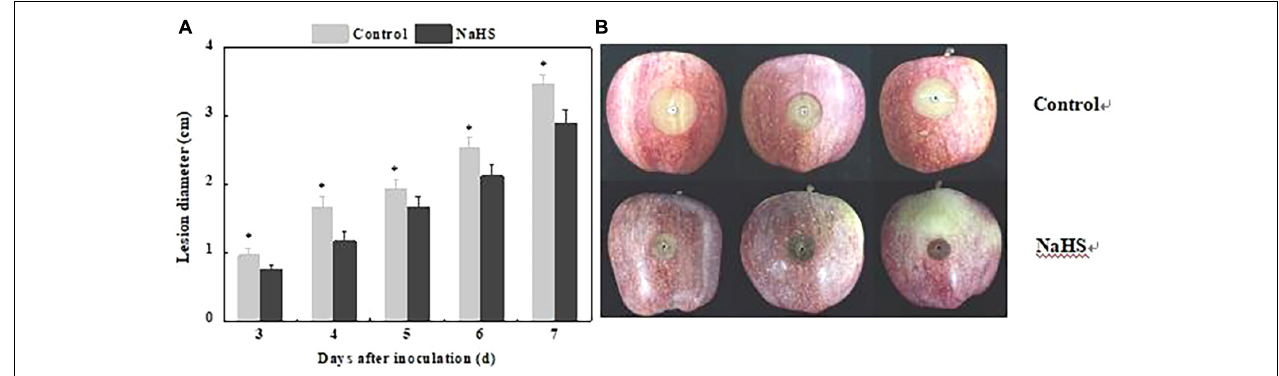
FIGURE 1 | Inhibition of Penicillium expansum -induced decay in apples by NaHS. The bars represent the standard error of the mean ( ± SE). The lesion diameter (A) and representative photographs were taken after 5 days (B) . ∗ Significant differences at P < 0.05.